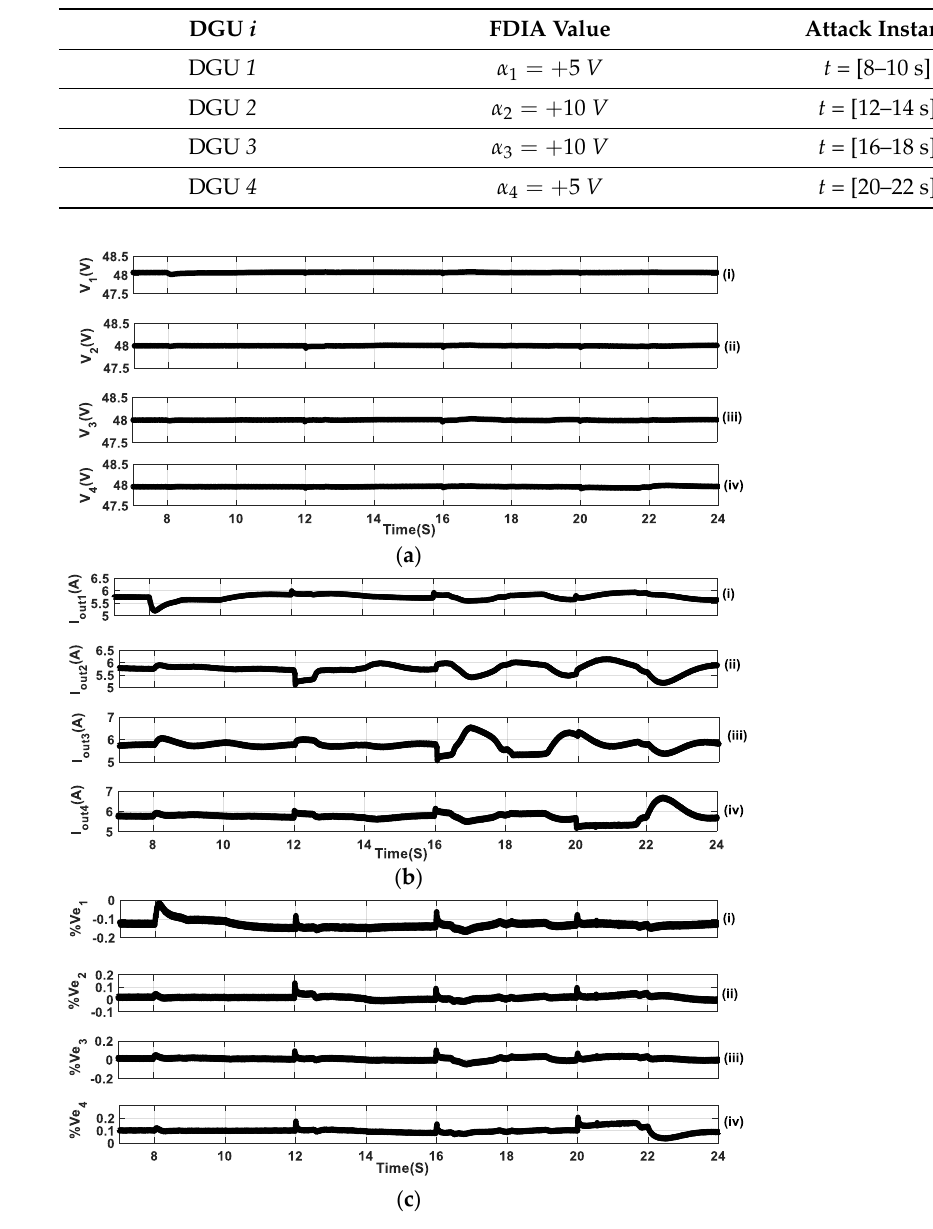
Table 4. Sequential voltage FDIA